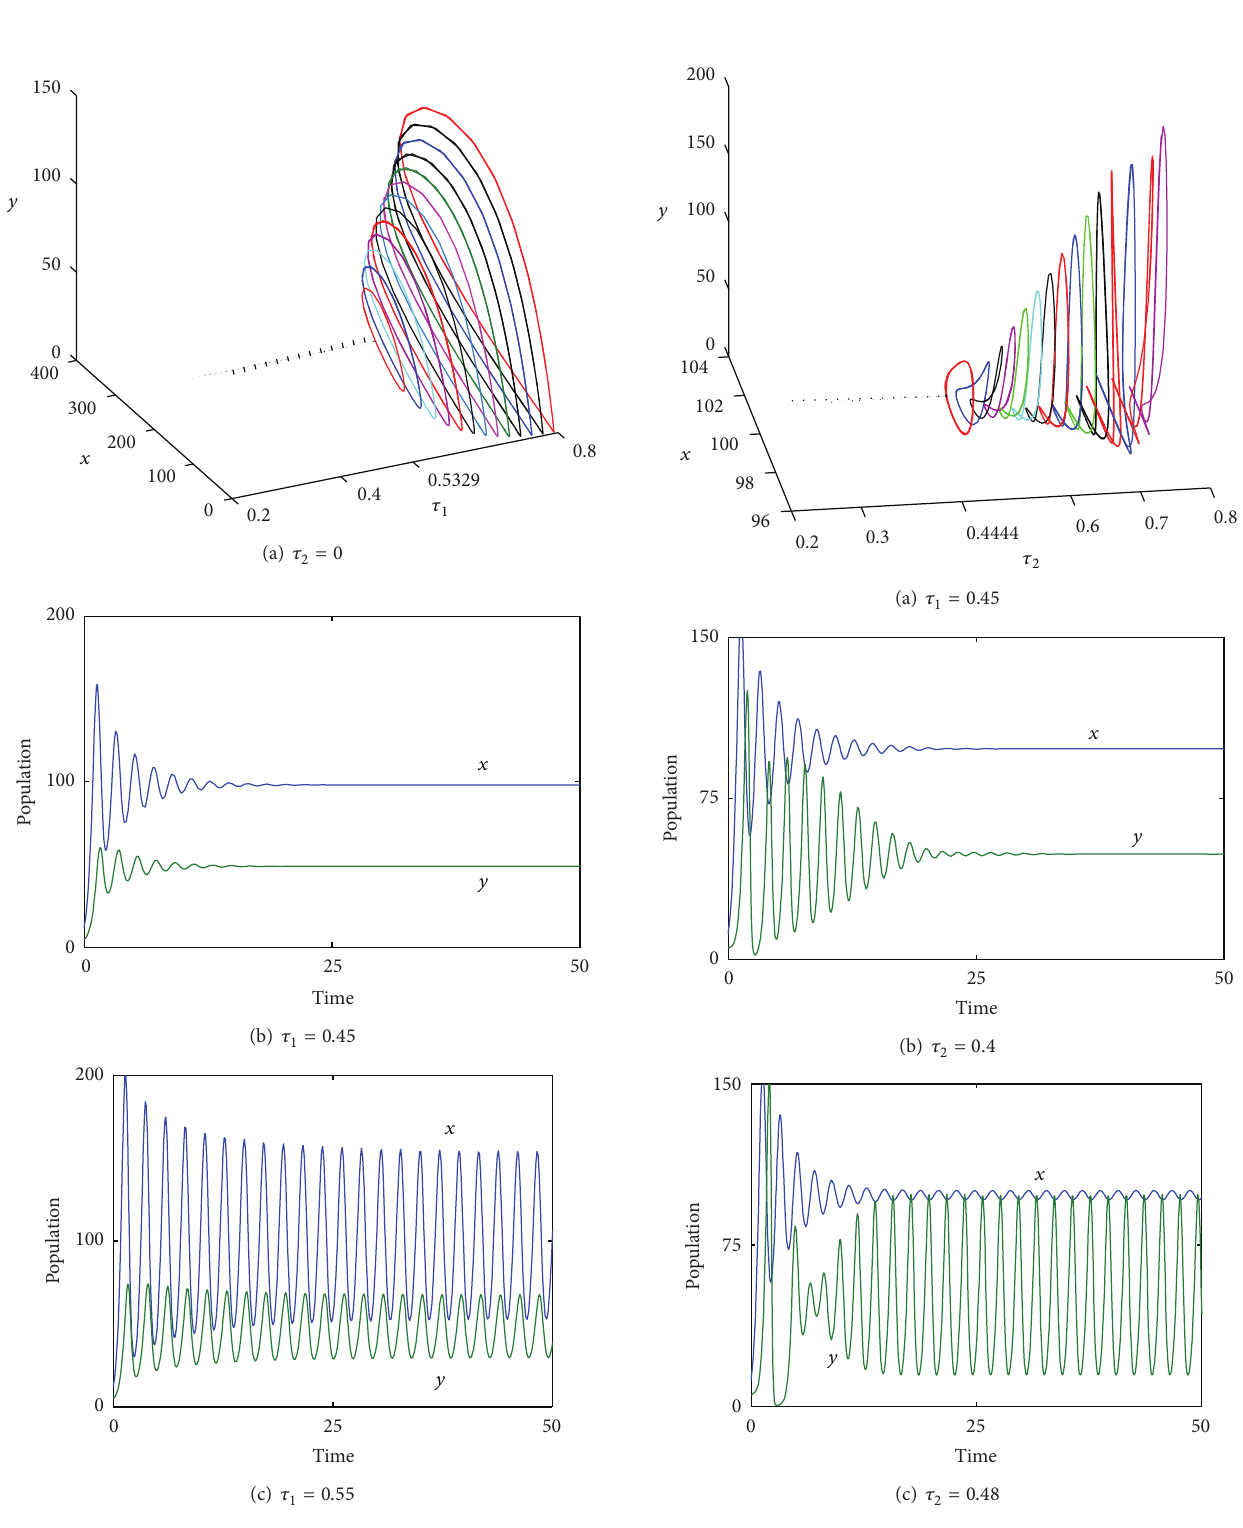
= 0.4444 0 = 0.4444 (system is unstable), 0